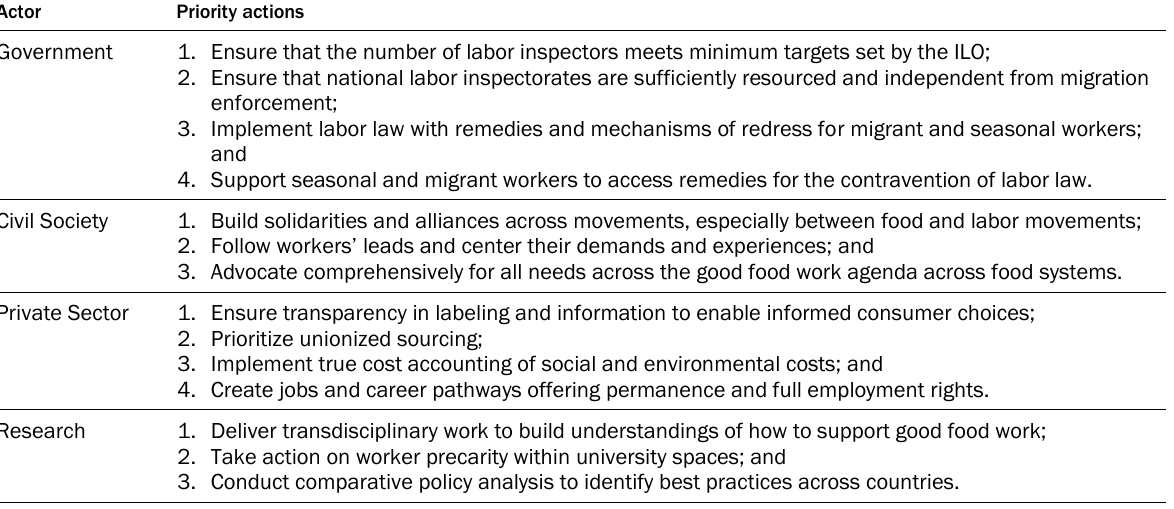
Table 2. Priority Actions to Advance Good Food Work for Key Actors in Government, Civil Society, the Private Sector, and